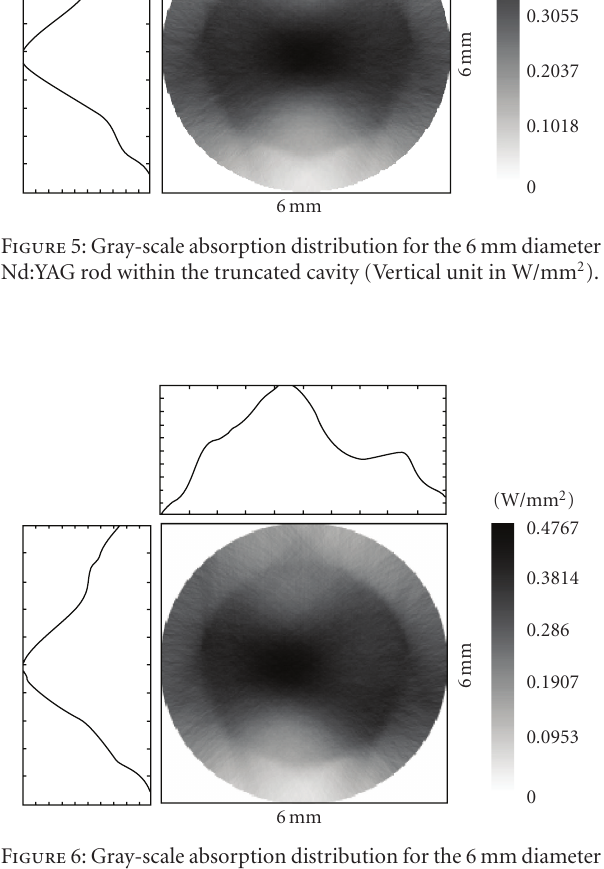
Figure 6: Gray-scale absorption distribution for the 6mm diameter Nd:YAG rod within the truncated cavity (angular tracking error 2mrad, vertical unit in W/mm 2 ).